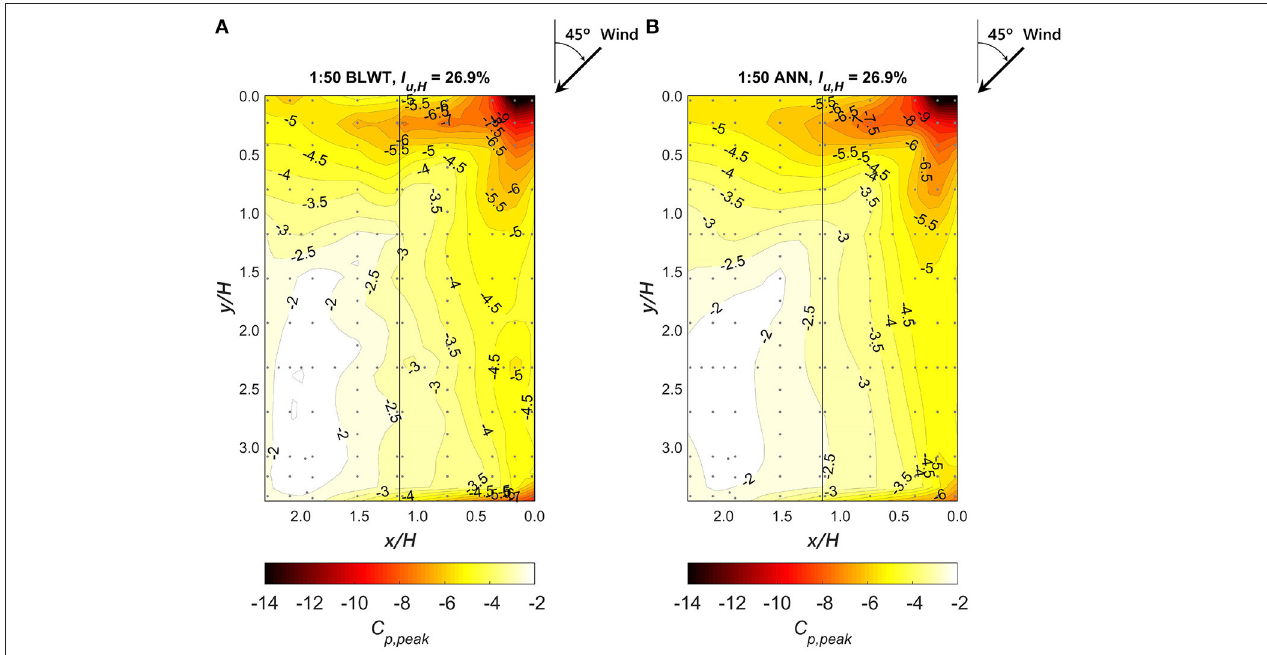
FIGURE 8 | Prediction of peak pressure coefficients ( C p , peak ) for the 1:50 WERFL model and a freestream turbulence intensity of 26.9% at eave height: (A) BLWT experimental data and (B) ANN prediction.